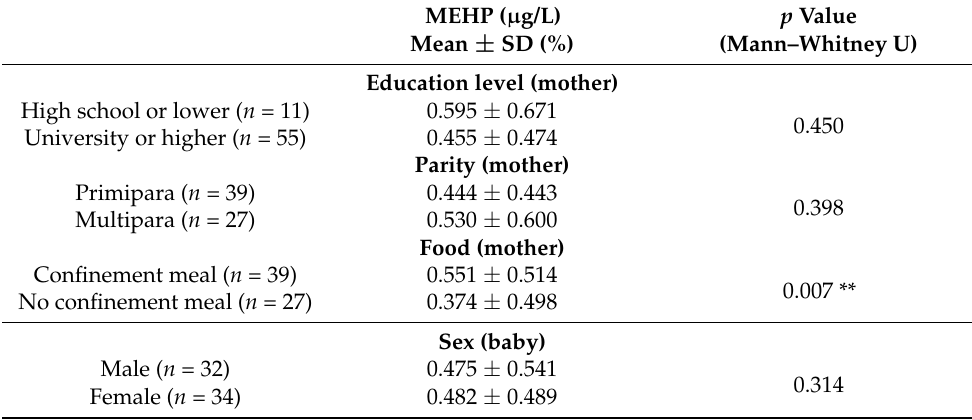
Table 3. Demographic characteristics and MEHP level in breast milk of study subjects.